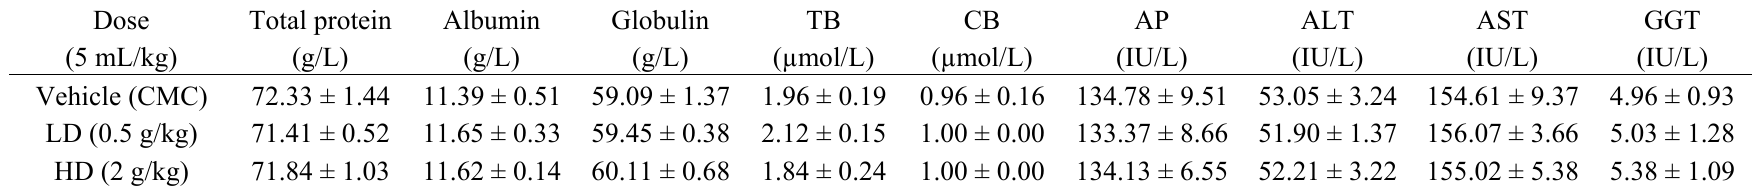
Table 2. Liver function test of rats in acute toxicity study of P. jiringa